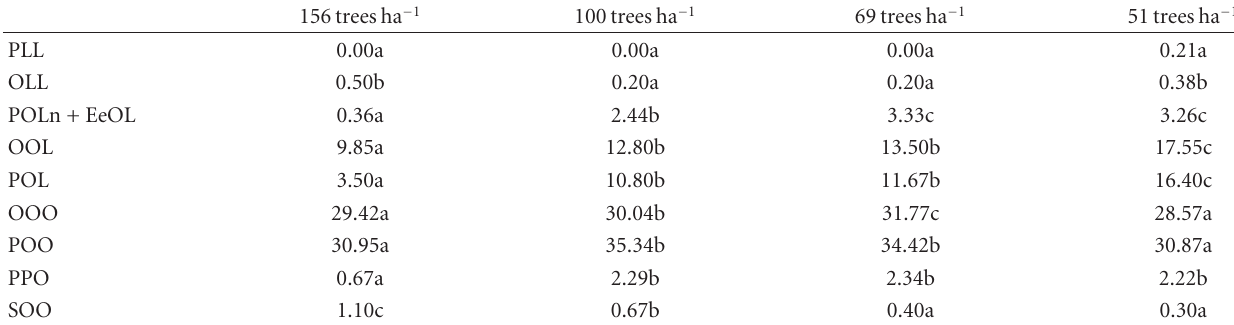
Table 2: Triacylglycerol composition of the studied olive